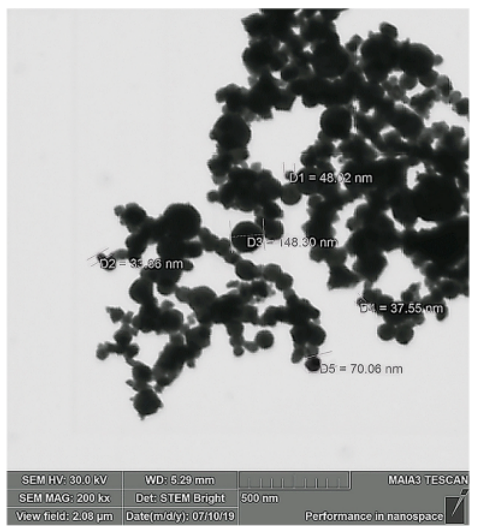
Figure 1. TEM micrograph of 1.0 M ethanolic suspension of commercial 25 nm zero valent iron nanoparticles (ZVI-NPs).